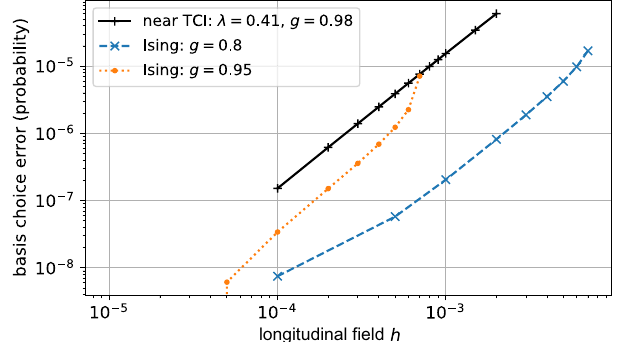
FIG. 14. Estimated error (1 − infidelity per site) on momen- tum eigenstates | φ( B , p ) (cid:3) for kink quasiparticles, due to the choice of orthogonality conditions on B used to achieve ( B ) | φ ( B ) (cid:3) = δ (cid:2) φ j k jk . Here we compare the left and right orthog-